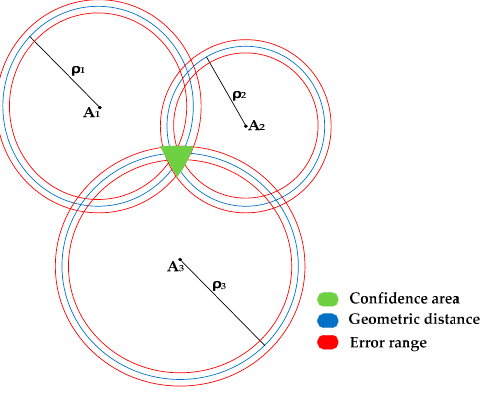
Figure 1. Multilateration position calculation.